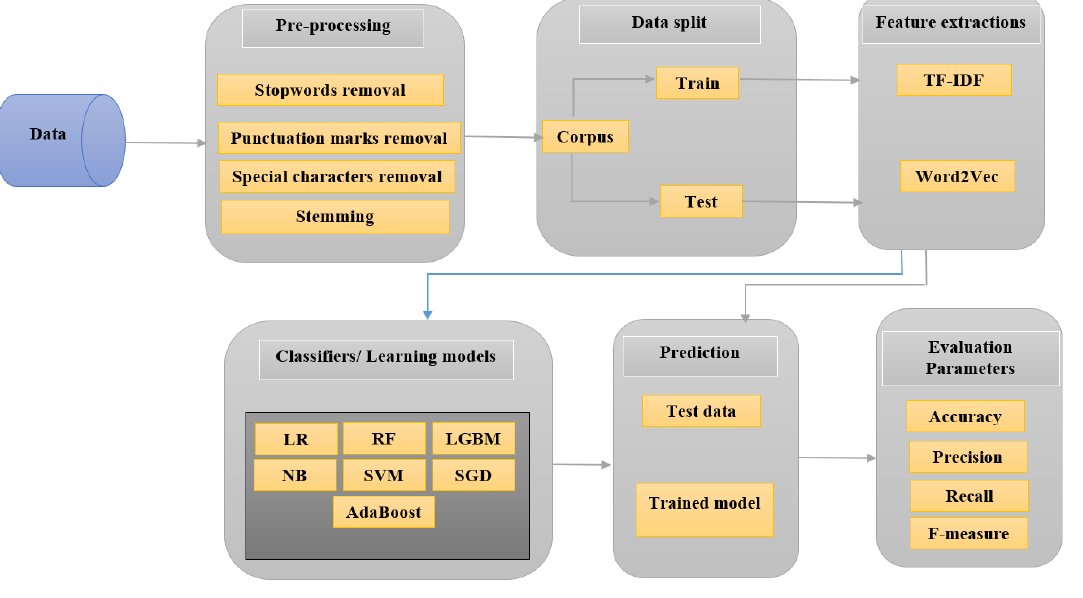
Figure 3. Overview of Cyberbullying Classification Pipeline.